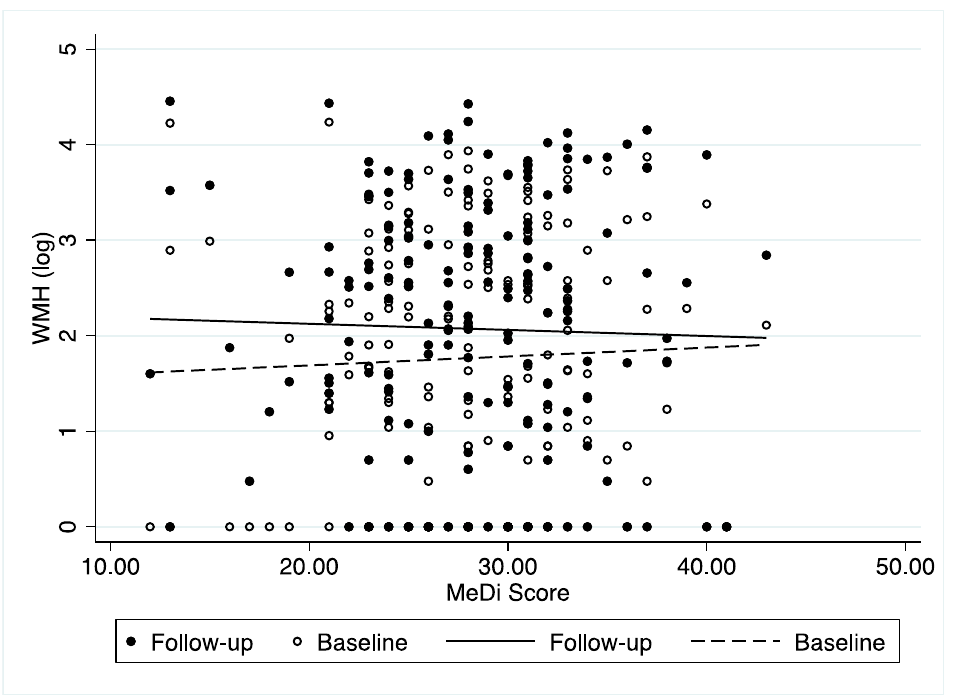
Figure 2. Relationship between Mediterranean diet score and white matter hyperintensity at baseline and follow-up visits. Table 2. Association between Mediterranean diet and change in white matter hyperintensity by population groups.